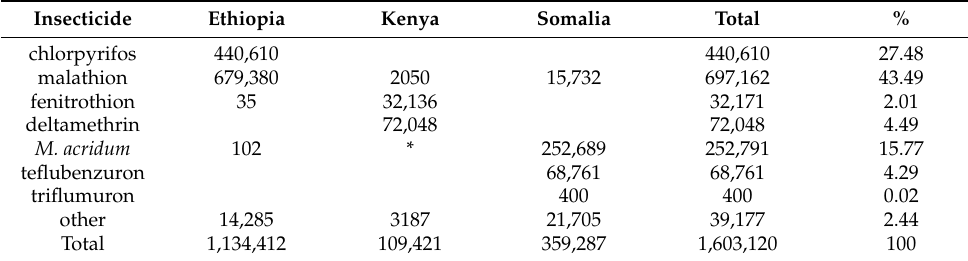
Table 2. Total surface area (ha) treated from 1 August 2019 to 31 December 2021. Data from the FAO Locust Hub [22]. From the available data, it cannot be deduced with certainty if some areas received multiple treatments. Missing aerial spray data for Kenya from March to October 2020 were obtained and added from the FAO’s Field Operations Officer [25]. These data had been uploaded to the SWARMS database, but not found there. M. acridum was used on a few 100 s ha in Kenya, but information was